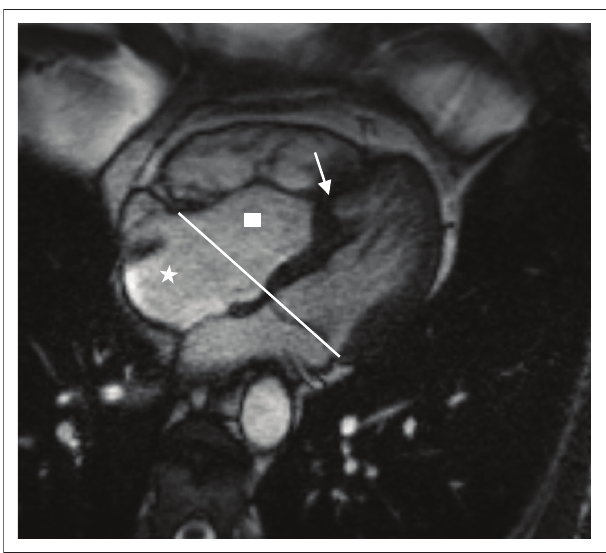
FIGURE 7: Four-chamber SSFP cine image demonstrates the apical displacement of the septal leaflet of the tricuspid valve (white arrow) from the level of the mitral valve annulus (white line). This results in a true right atrium ( * ) and an atrialised portion of the right ventricle (white square), and a reduced functional right ventricle volume.